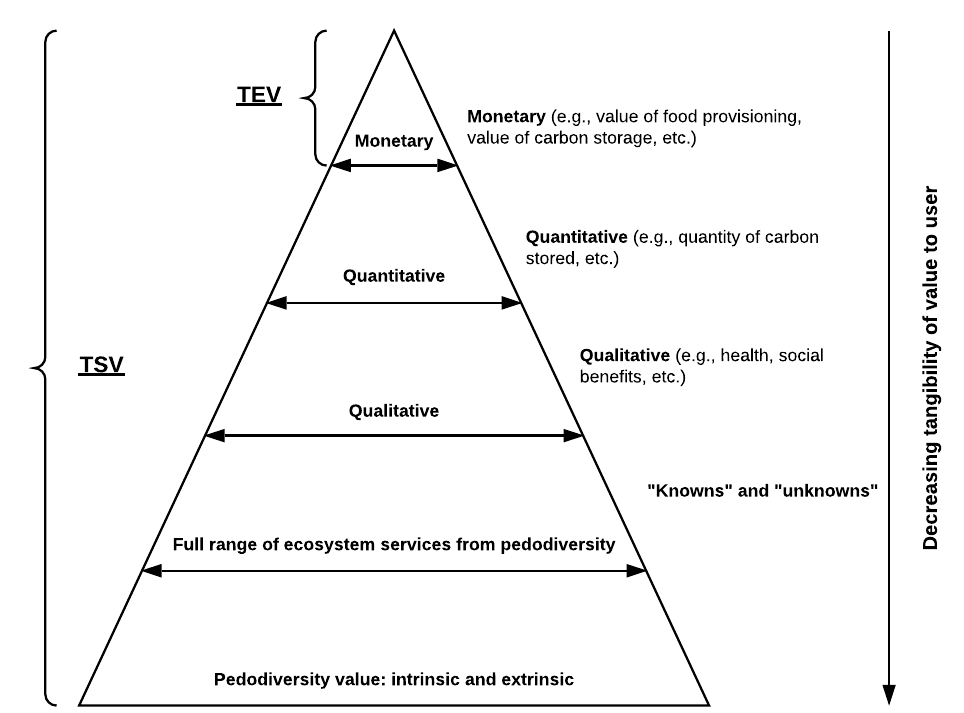
Figure 10. The newly expanded scope of pedodiversity valuation pyramid with a comparison of total economic value (TEV) and total system value (TSV) of ecosystem services (ES) and disservices (ED) (adapted from Gantioler et al., 2000